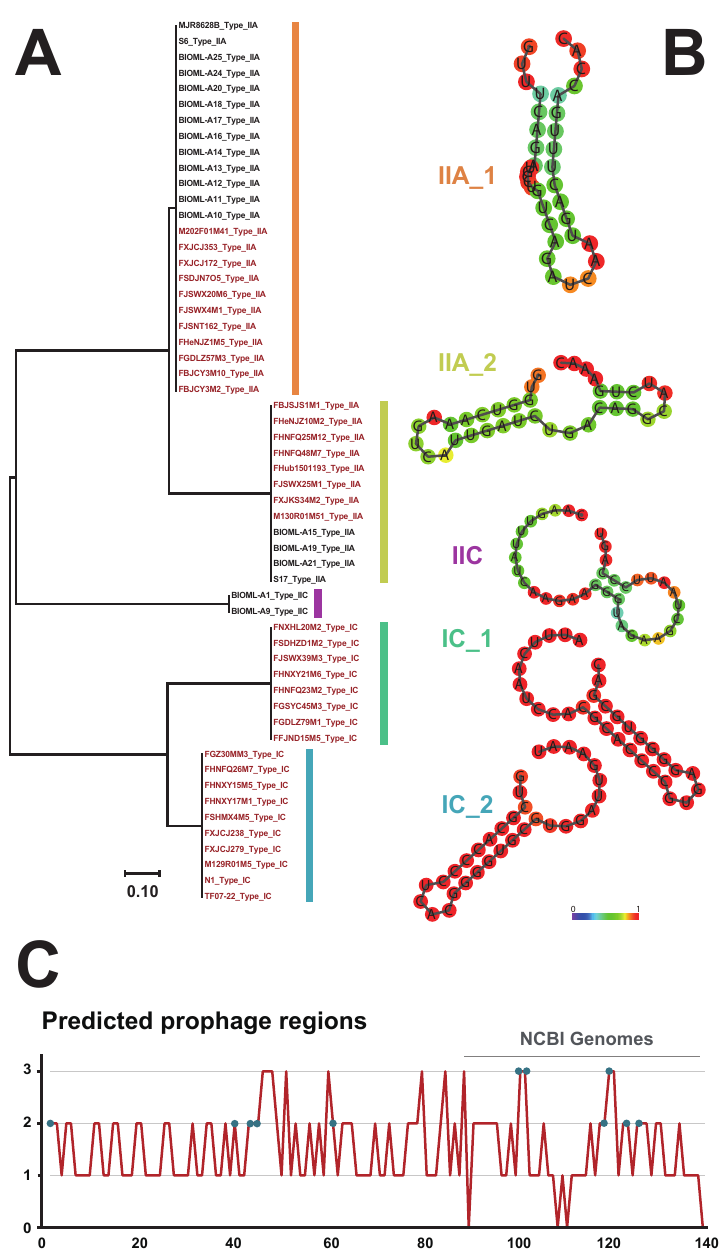
Figure 4. The phylogenetic tree based on direct repeat sequences ( A ), the color bars represent different subtypes of CRISPR-Cas systems in B. bifidum genomes. The secondary structures of the repeat sequences in B. bifidum strains ( B ), the color in each circle represents the frequency of the amino acid with a gradient from blue (low) to red (high). The prophage regions were identified in B. bifidum strains ( C